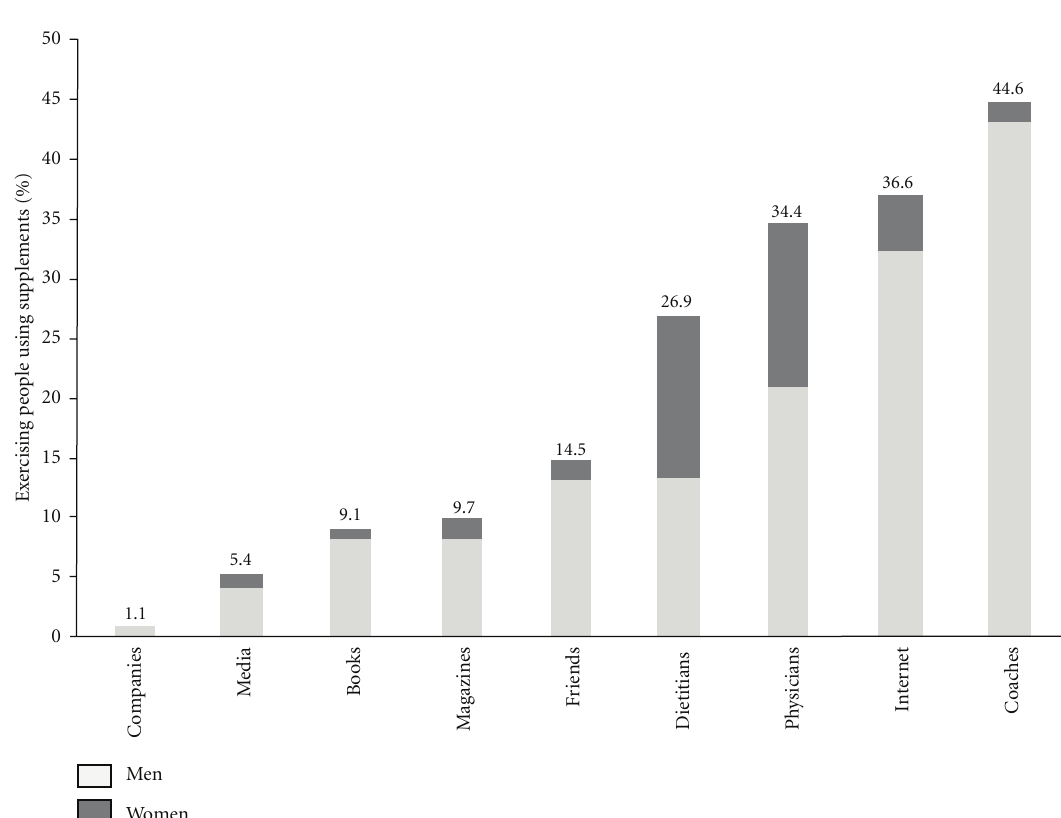
Figure 3: Sources of information among supplement users ( n = 186). There are no missing